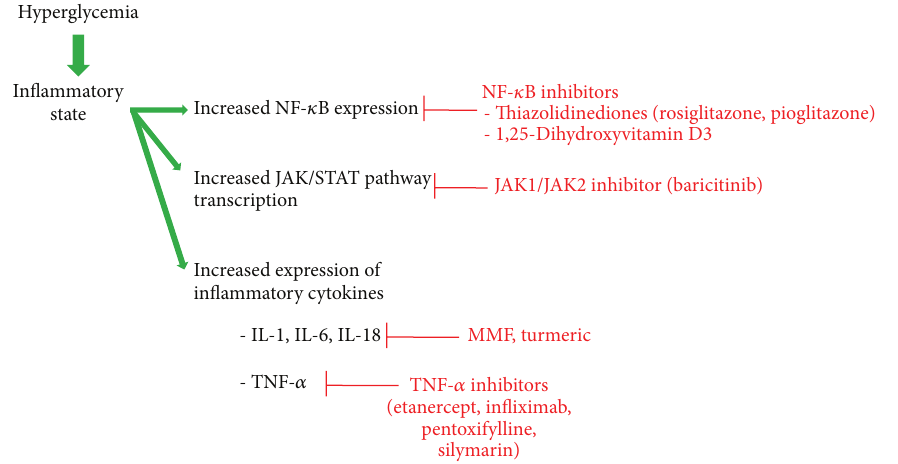
Figure 3: A schematic summary of the therapeutics that have been identified in the inflammatory pathway. The inflammatory state occurs as a result of hyperglycemia and is seen in patients with both type 1 and 2 diabetes.